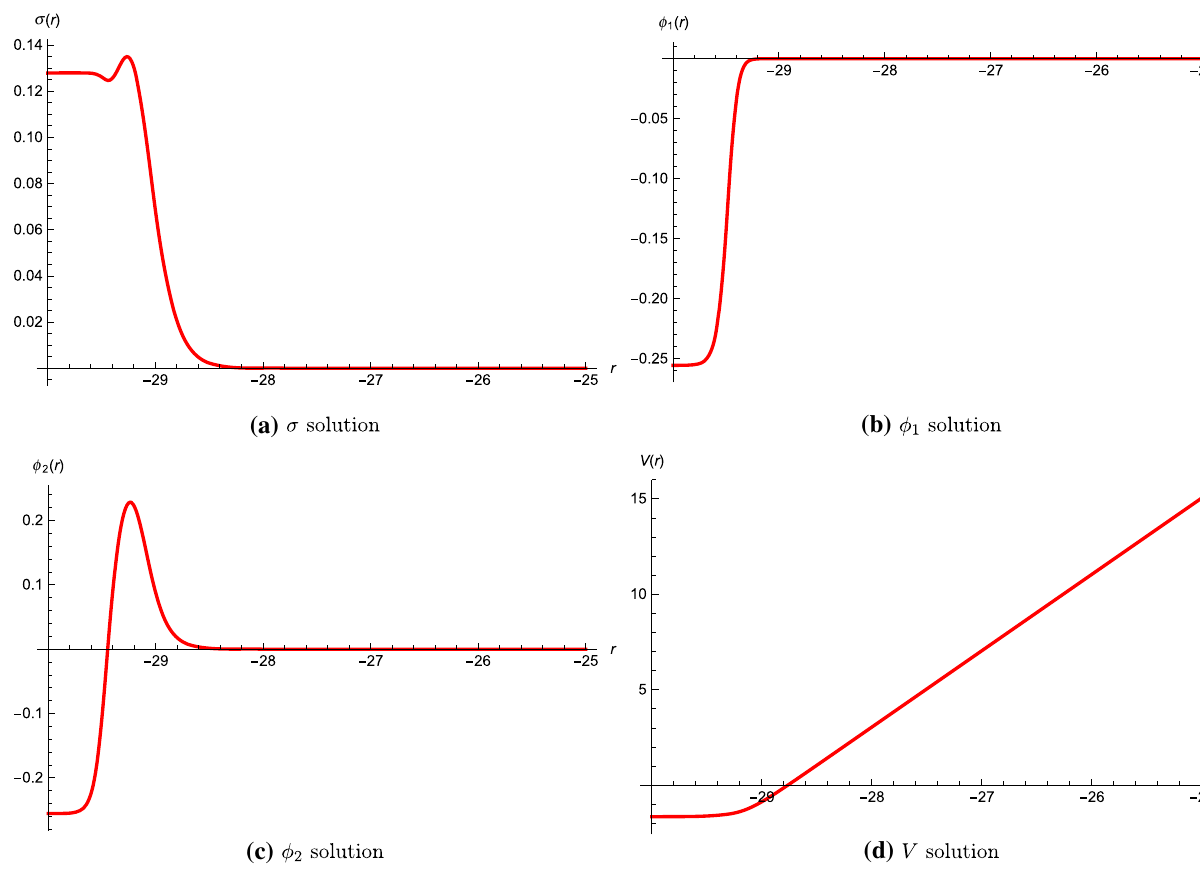
Fig. 12 An RG flow from SO ( 4 ) N = ( 1 , 0 ) SCFT in six dimensions to two-dimensional N = ( 2 , 0 ) SCFT with SO ( 2 ) diag symmetry dual to AdS 3 × CH 2